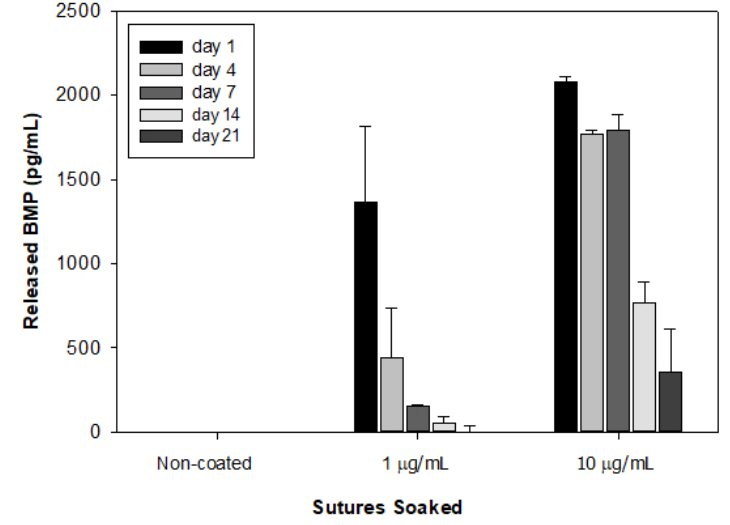
Figure 2. In vitro release assay of BMP-2 concentrations in elution at day 1, 7, 14, and 21